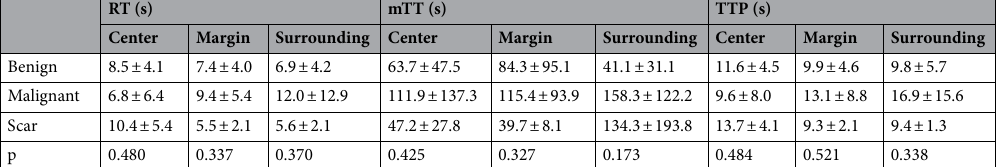
Table 2. Numeric values for perfusion analysis for Rise Time (RT) and mean Transit Time (mTT) and Time to Peak (TTP) for the Regions of Interest (ROI) in the center, at the margin and the surrounding tissue for benign and malignant lesions as well as for